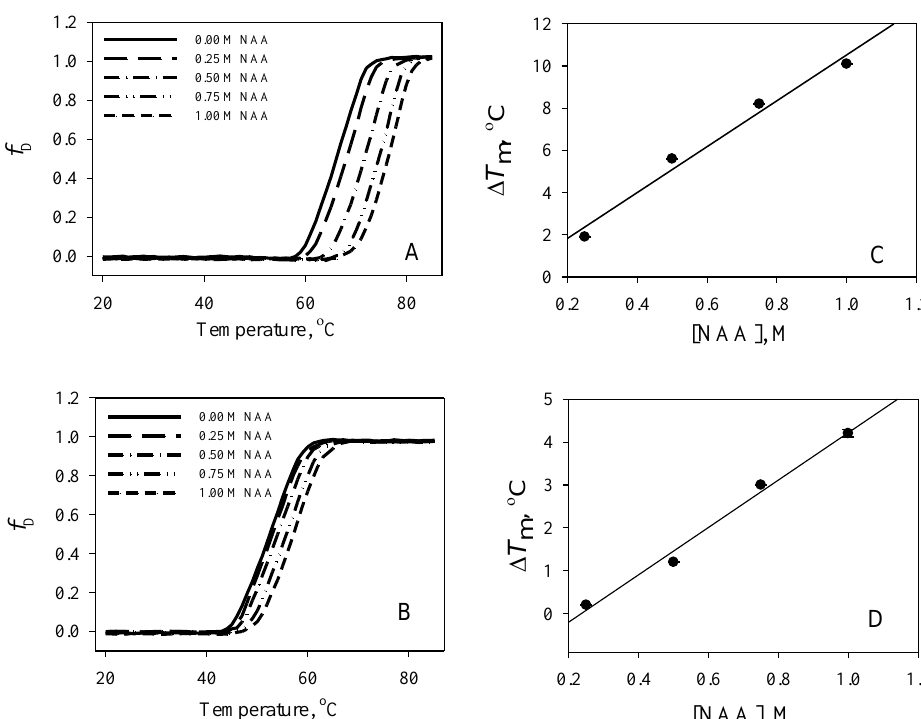
Figure 2. Thermal denaturation profiles of lysozyme at pH 7.0 and pH 2.5. Left panels: Denaturation curves of lysozyme at pH 7.0 ( A ) and at pH 2.5 ( B ) in the absence and presence of various NAA concentrations. Right panels: Plots of ∆ T m versus NAA of lysozyme at pH 7.0 ( C ) and at pH 2.5 ( D ).The protein concentration used was 58 µM. Table1. ThermodynamicparametersofRNase-Aandlysozymeinthepresenceofdifferentconcentrations of NAA a,b,c .